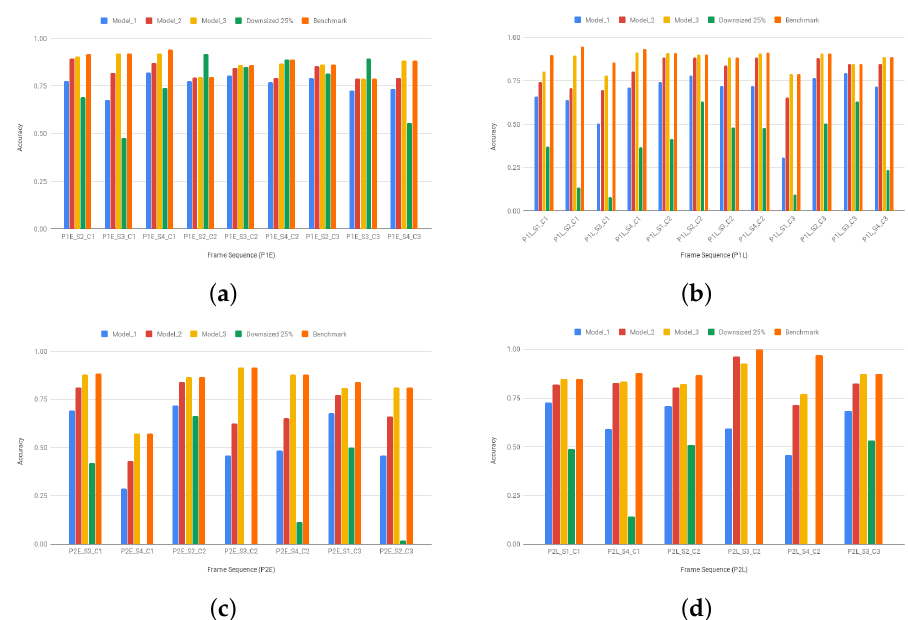
Figure 10. Mean face recognition accuracy regarding each evaluated model, the images resized to 25% of their original sizes, and the benchmark images from the ( a ) P1E, ( b ) P1L, ( c ) P2E, and ( d ) P2L